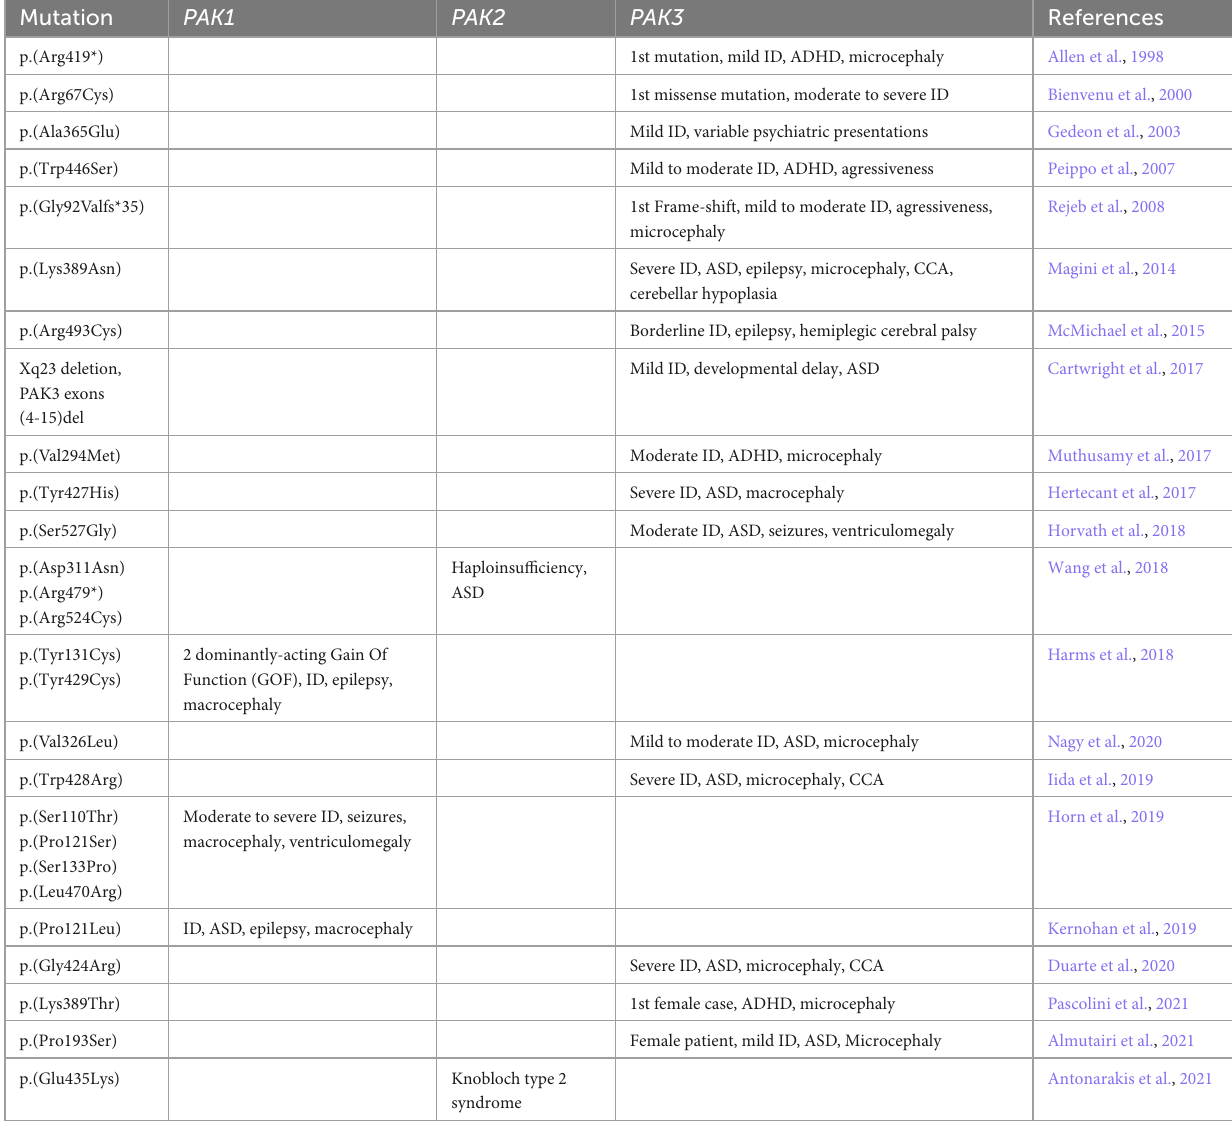
TABLE 1 Historical discoveries of PAK variations in